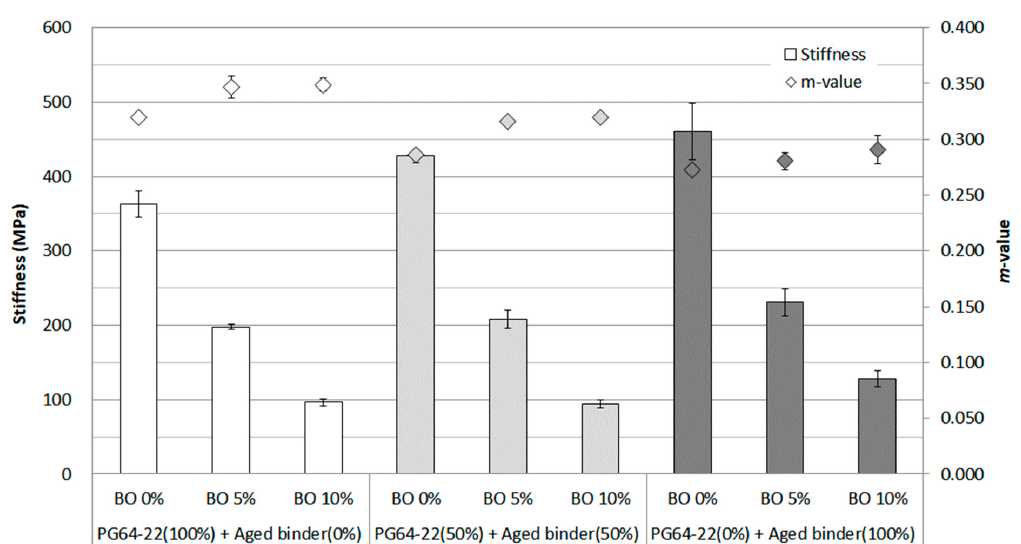
condition at − 12 ◦ C.